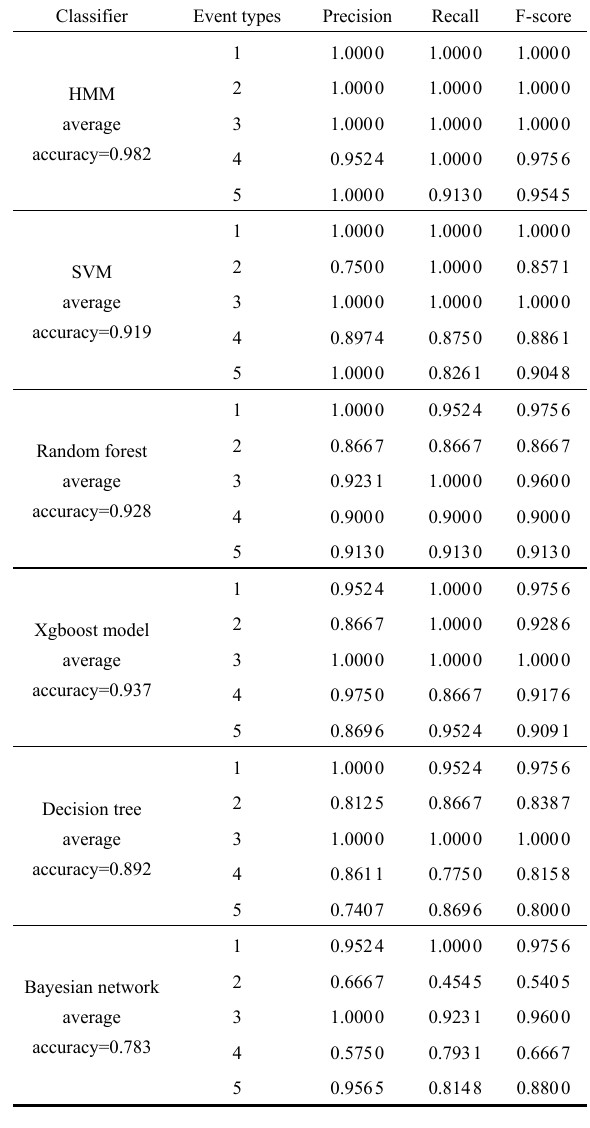
Table 1 Comparison of recognition results for the six methods.